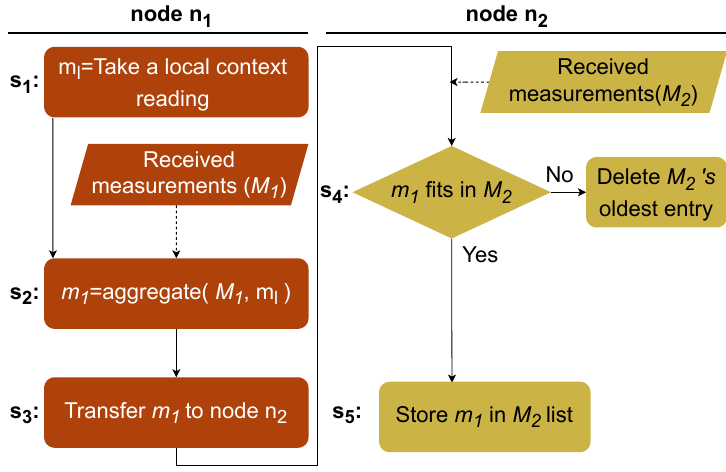
Figure 2. Context measurements dissemination when two nodes are in